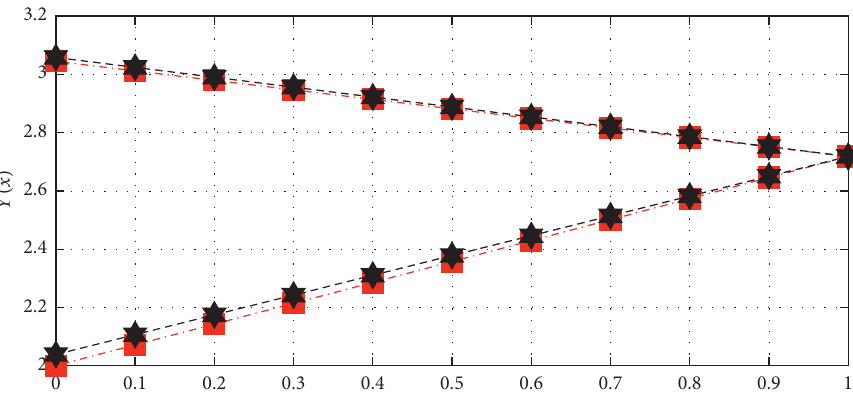
Figure 3: The exact and computed solution for Example 1. Yellow chart indicates real data and black chart indicates approximate